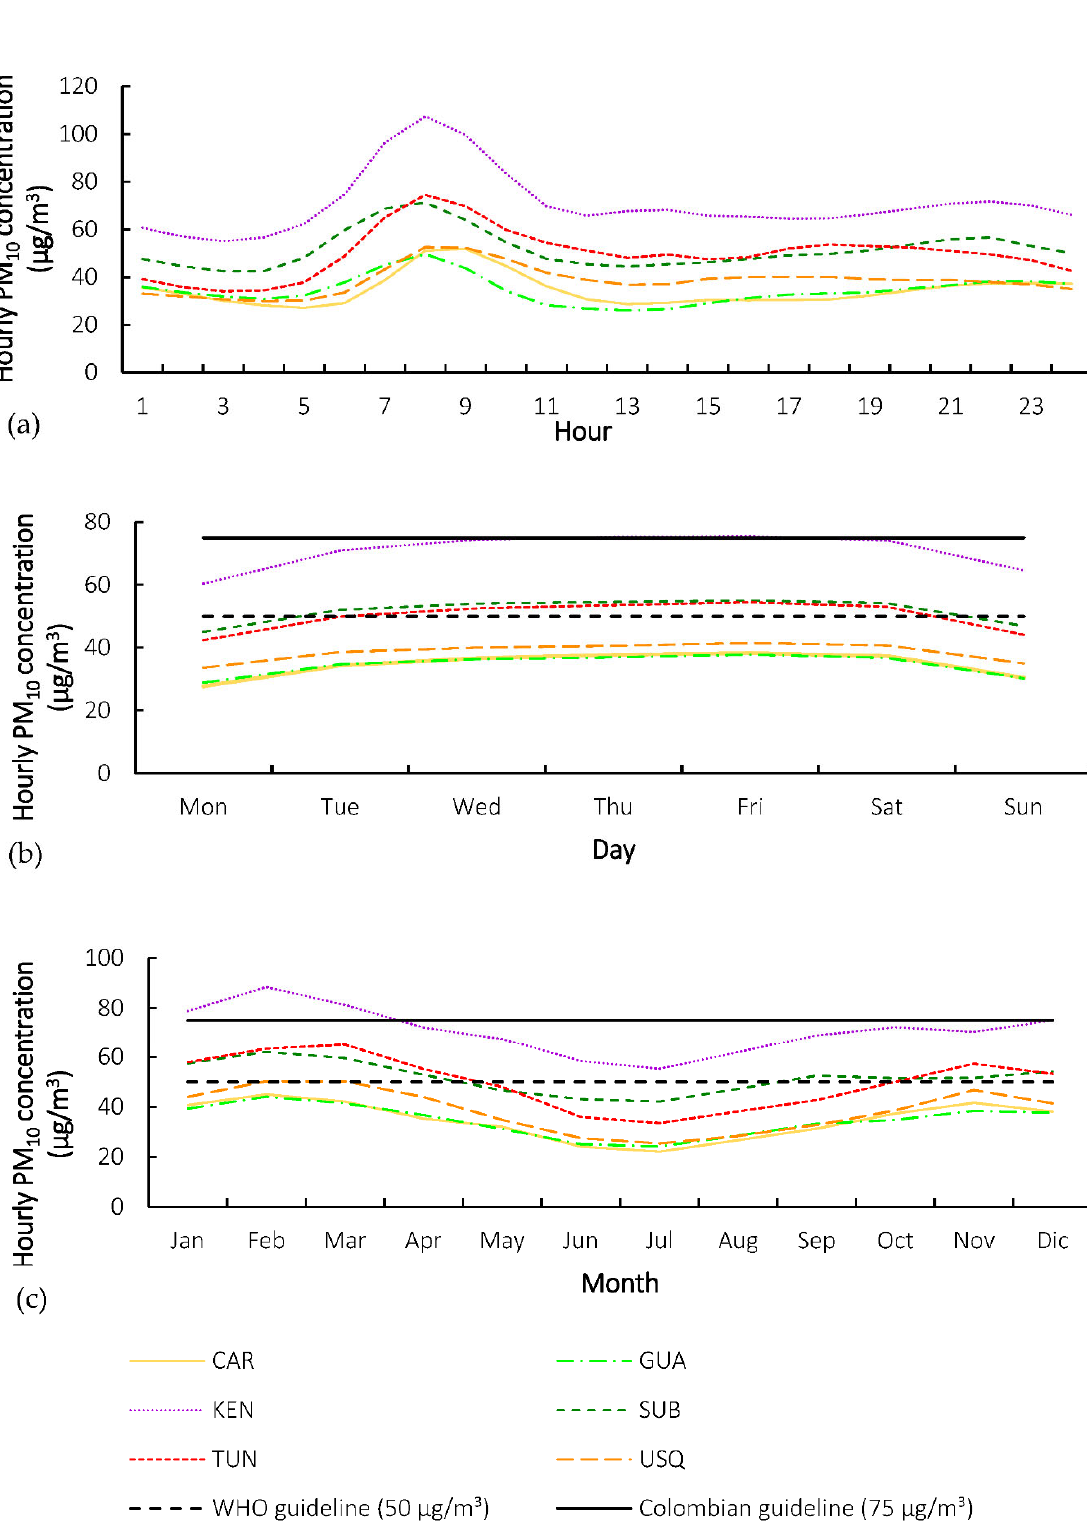
Figure 2. Average PM 10 concentrations under the ( a ) hourly, ( b ) daily, and ( c ) monthly time scales.